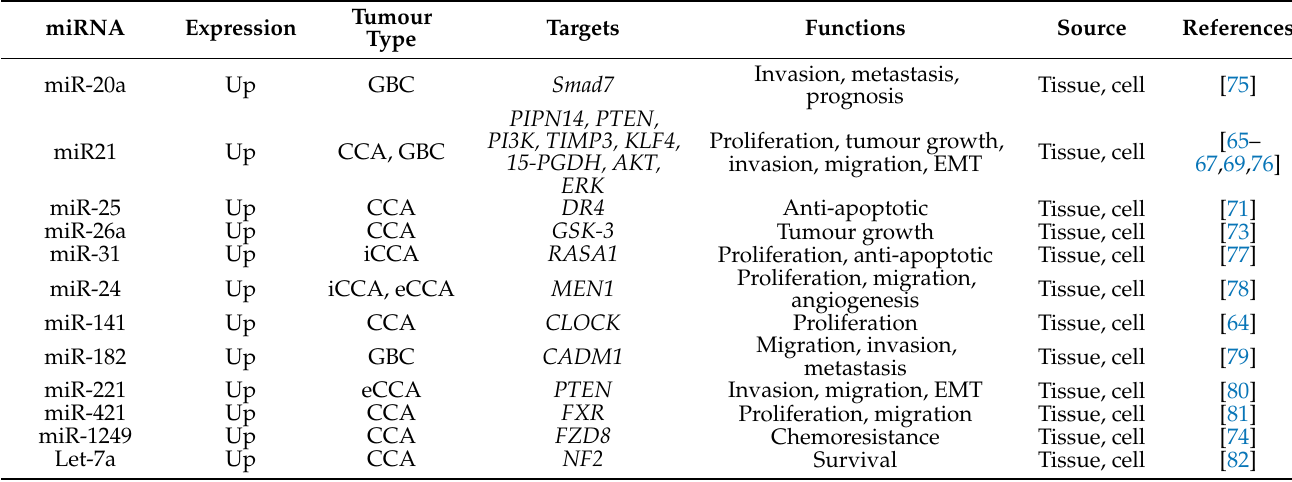
Table 1. Oncogenic miRNAs and their role in biliary tract